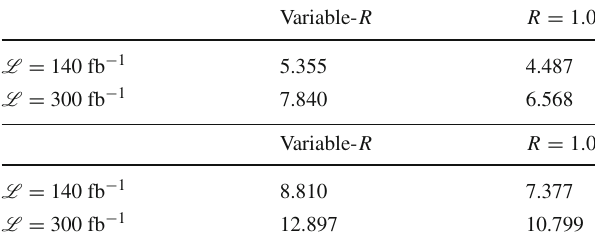
Table 4 Upper panel: final (cid:16) values calculated upon enforcing the initial cuts plus the mass selection criteria of Fig. 8 for the two jet reconstruction procedures. Lower panel: The same in presence of K - factors